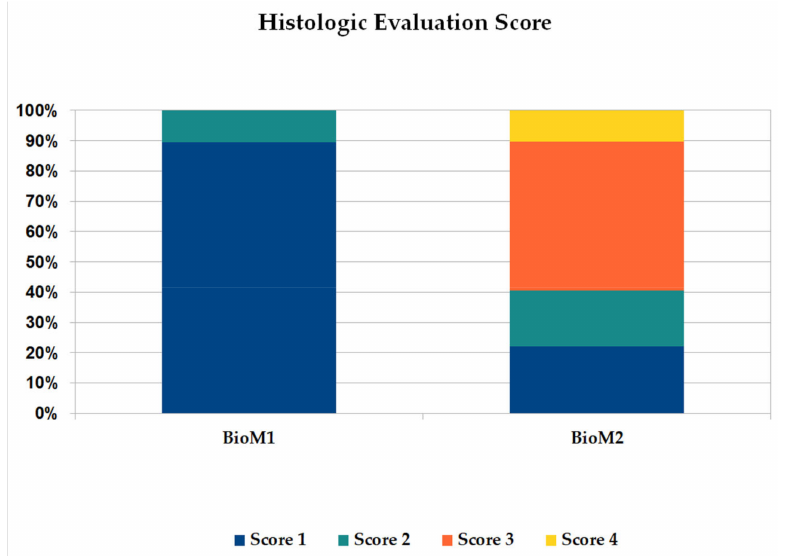
Figure 4. Summary of the four-graded histological evaluation score after implantation of BioM1 and BioM2 for 12